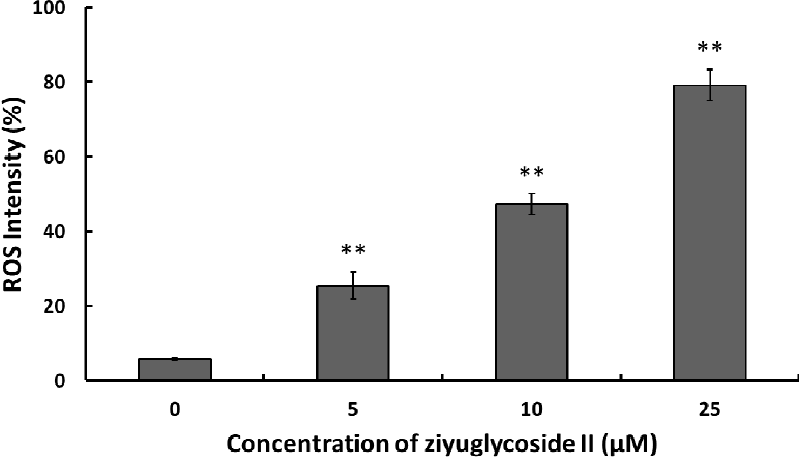
Figure 3. The effect of ziyuglycoside II on the generation of ROS in MDA-MB-435 cells. Cells were incubated with various concentrations of ziyuglycoside II for 6 h and then harvested for ROS determination as described in Materials and Methods. All data were expressed as mean ± SD of three experiments and each experiment included triplicate repeats. * p < 0.05, ** p < 0.01 vs. control.